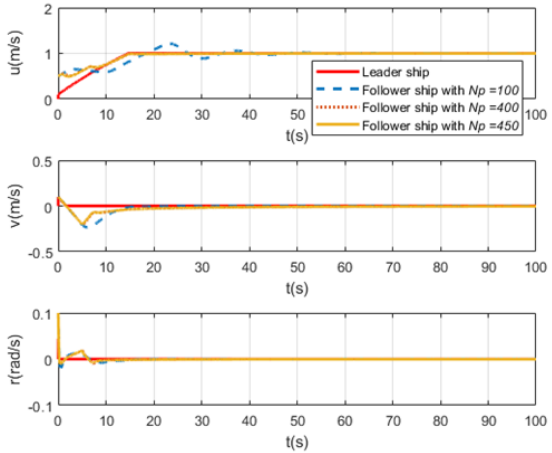
Figure 6. The synchronization of velocities with disparate prediction horizon.